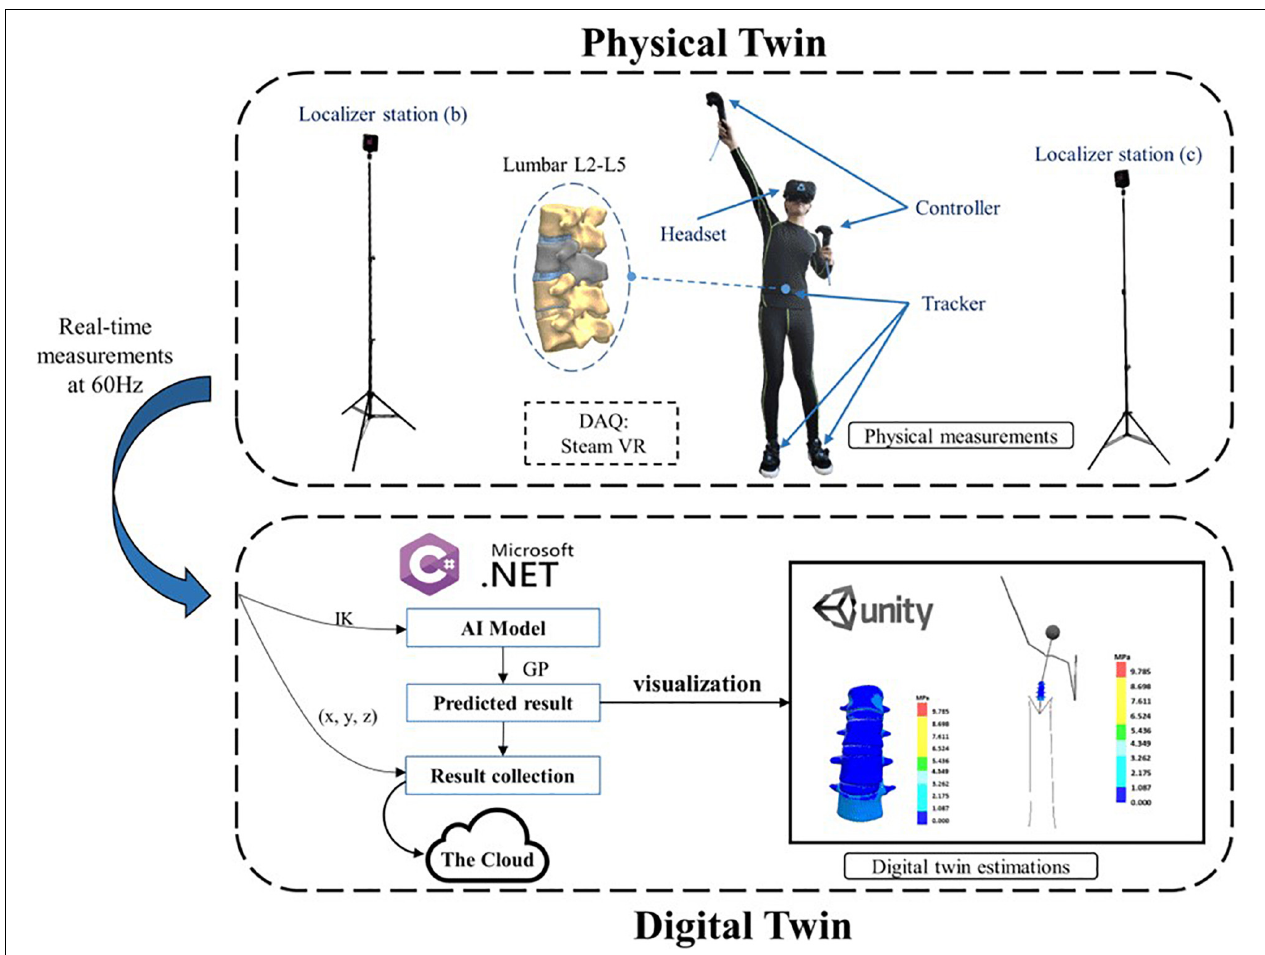
FIGURE 2 | Toward a shape–performance integrated digital twin for lumbar spine analysis